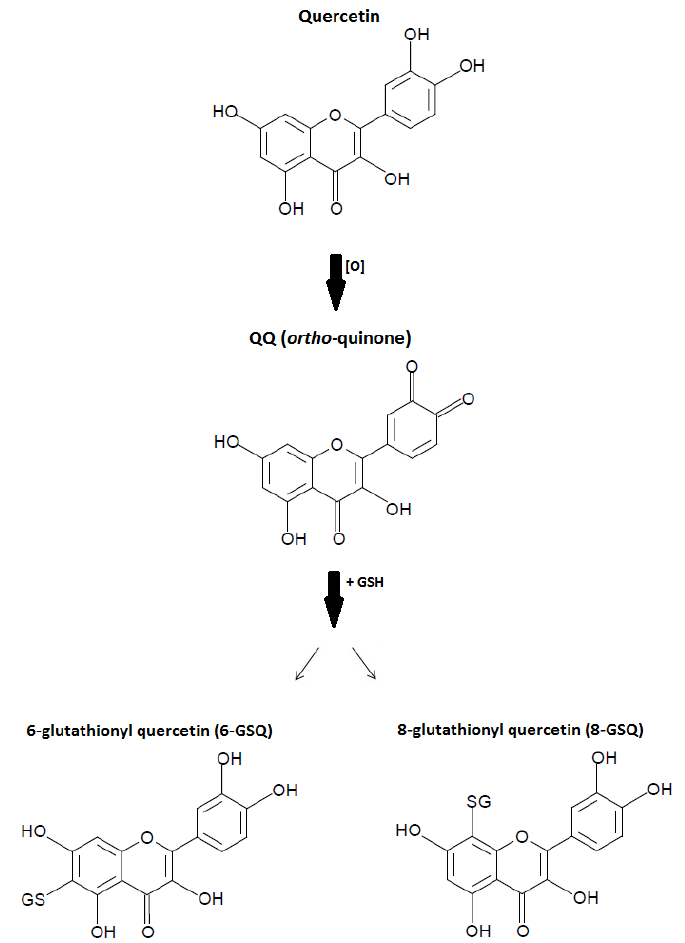
Figure 4. Antioxidative mechanism of quercetin. Quercetin is oxidized into oxidation products (QQ: ortho-quinone) and reacts with glutathione (GSH) to form 6-glutathionyl quercetin (6-GSQ) and 8-GSQ.